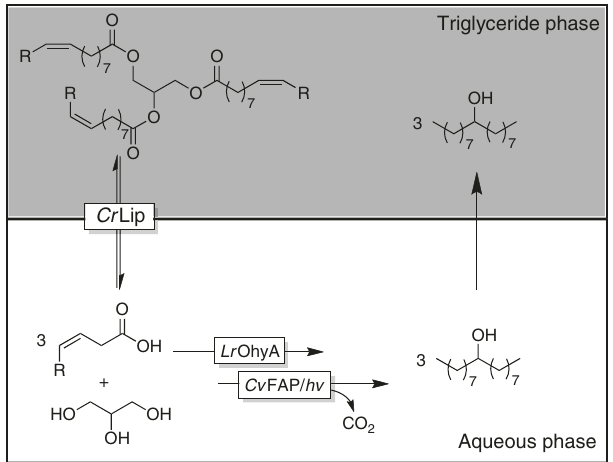
Fig. 5 Trienzymatic cascade for the transformation of triolein into 9- heptadecanol using a two-liquid-phase approach. The aqueous reaction medium is supplemented with neat triolein (triglyceride phase) serving as substrate reservoir and product sink. In the reaction sequence, triolein is hydrolysed by the lipase from Candida rugosa ( Cr Lip, located at the interphase) liberating glycerol and oleic acid. The latter is hydrated and decarboxylated (catalysed by Lr OHyA and Cv FAP) yielding 9-heptadeconol, which partitions back into the hydrophobic